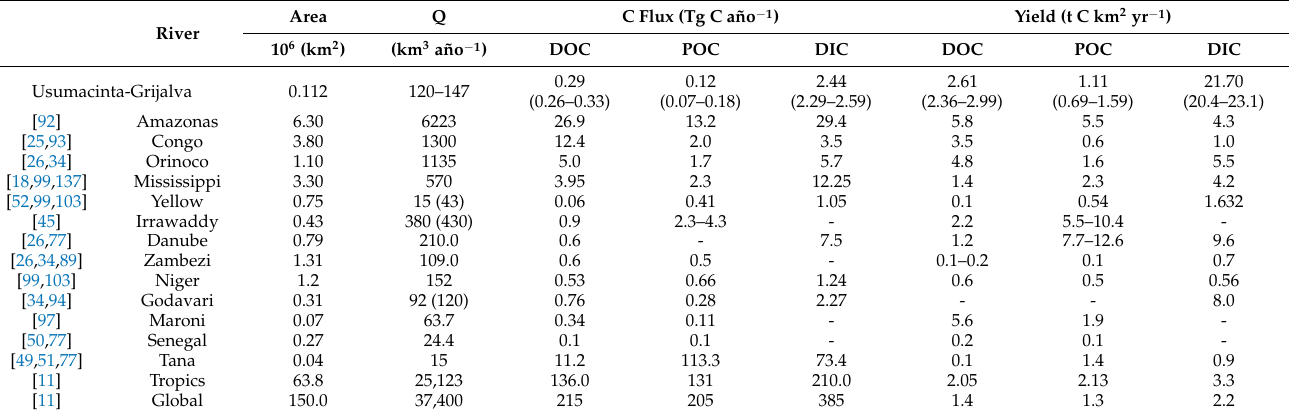
Table 4. Comparison of the C flux in the Grijalva-Usumacinta system (estimated at the mouth) with the principal rivers of the world. (The Mississippi, Danube, and Yellow rivers are temperate, and the rest are tropical. The area and Q are from [91] data. Flows in parentheses indicate the previous values before the flow reduction due to the construction of reservoirs and irrigation. The C flux for the Tana River is in Gg yr − 1 , 1 Gg = 10 3 t. 1 Tg = 10 6